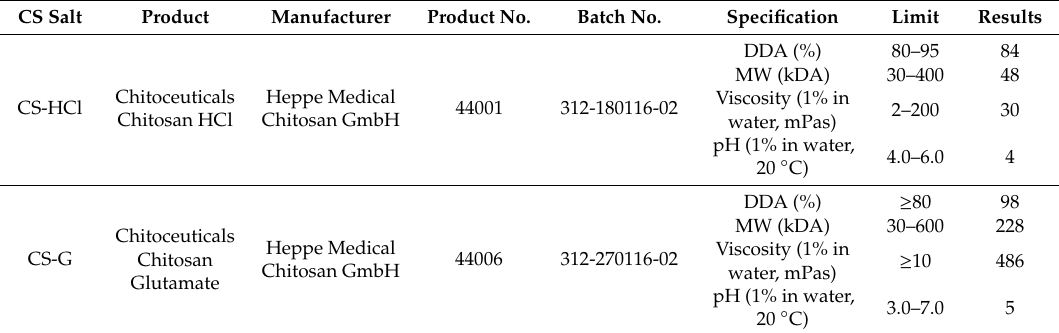
Table A1. CS salts specifications given by the manufacturer.